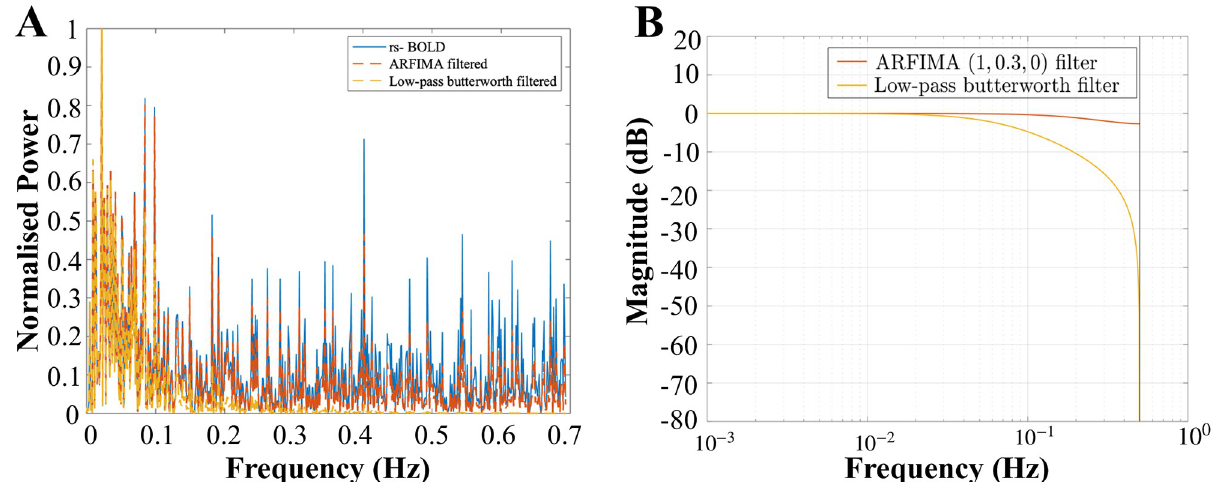
Fig 11. Comparison between the derived ARFIMA filter and first-order low-pass butterworth filter. Both the figures show the comparison made on ROI: 11 corresponding to the somatomotor auditory region of the brain. (A) Normalised power spectrum of the unfiltered and filtered BOLD signal. The normalised power spectrum corresponding to the preprocessed resting-state BOLD signal is represented by the cyan curve, low-pass first-order butterworth filtered by yellow curve and the ARFIMA (1, 0.3, 0) filtered BOLD by the orange curve. (B) Magnitude bode plot of the transfer function of the low-pass first-order butterworth filter (yellow curve, cut off frequency: 0.1Hz) and the derived ARFIMA (1, 0.3, 0) filter (orange curve).